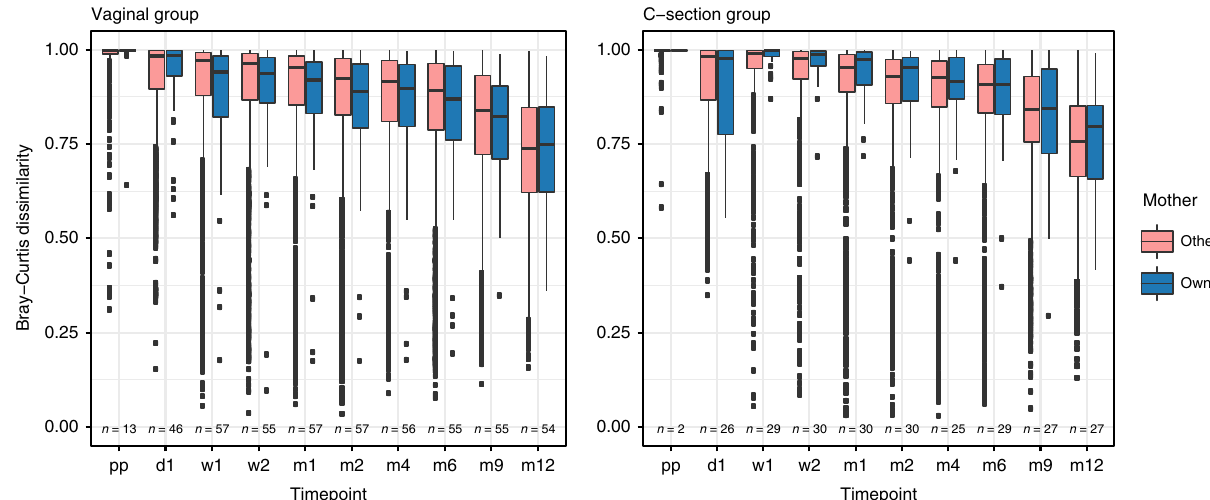
Fig. 3 Comparison of overall composition between children and mothers (own vs. other). Children ’ s fecal microbiota were compared to the mothers ’ fecal microbiota, based on BC dissimilarity and strati fi ed according to mode of delivery. A signi fi cantly lower dissimilarity (more comparable microbiota) was observed between a child ’ s microbiota and its own mother vs. other mothers in children born vaginally throughout the fi rst year of life, but not in children born by C-section (linear mixed models, ANOVA; p = 0.025 and p = 0.271, respectively). Boxplots with medians are shown; the lower and upper hinges correspond to the fi rst and third quartiles (the 25th and 75th percentiles); the upper and lower whiskers extend from the hinge to the largest and smallest value no further than 1.5*IQR from the hinge; outliers are plotted individually. Pp = postpartum, d = day, m = month, n = number of mother-own-infant pair comparison per timepoint. Source data are provided as a Source Data fi